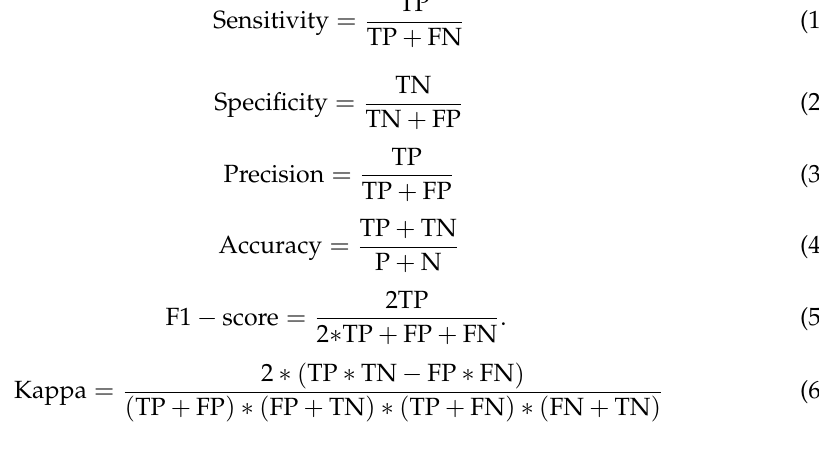
Table 4. Confusion